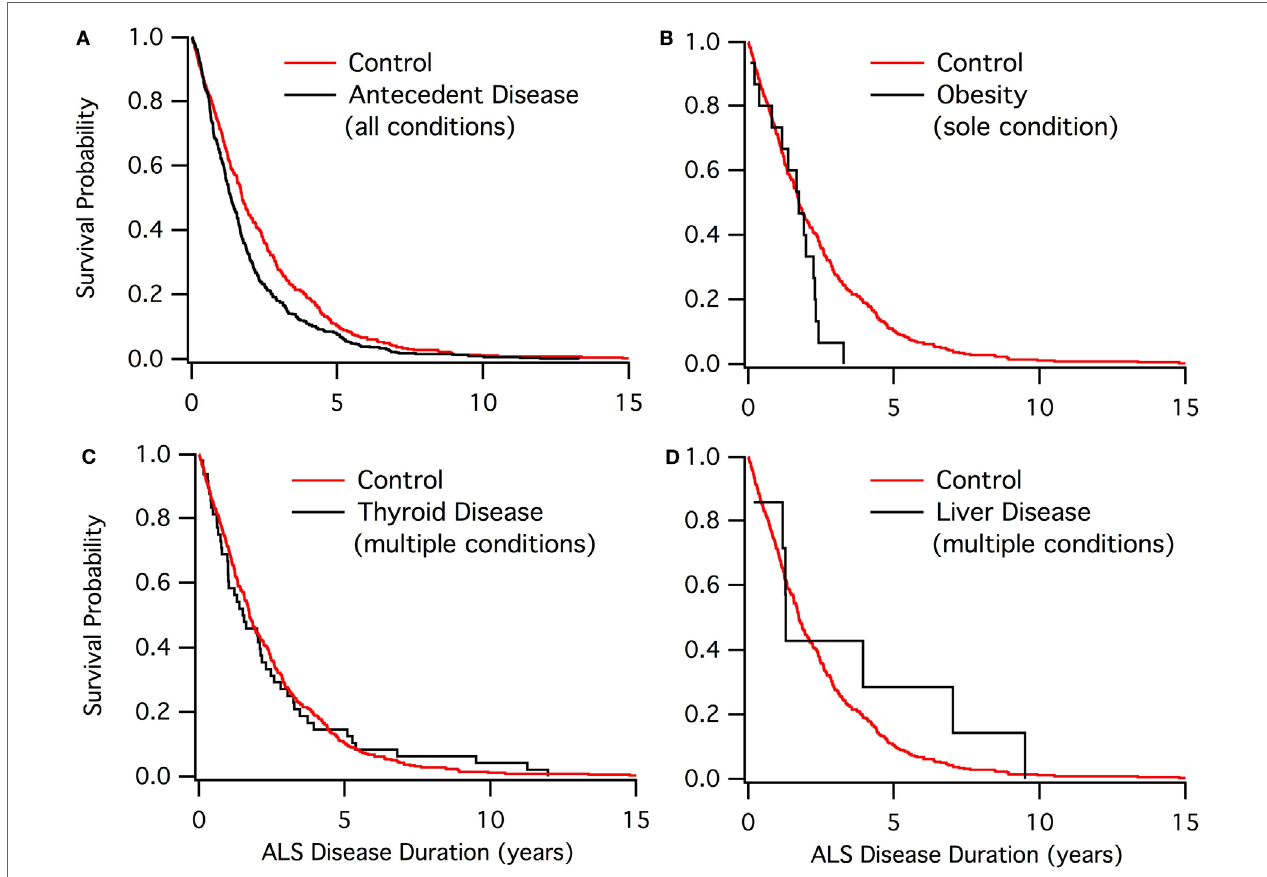
FigUre 1 | Kaplan–Meier graphs of als disease duration population . (a) Control group (red) compared to those with at least one antecedent condition. (B) Control group (red) compared to the obesity sole group. (c) Control group (red) compared to those who have thyroid disease. (D) Control group (red) compared to those who have liver